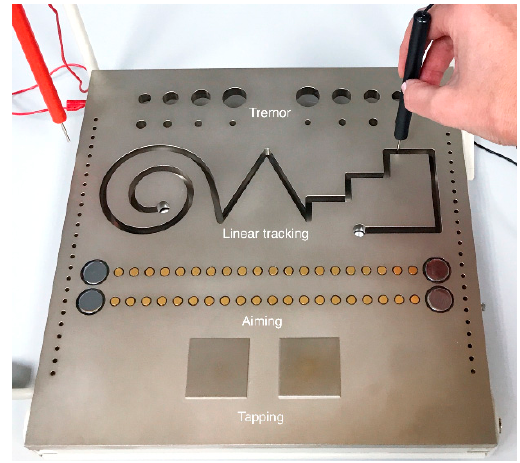
Figure 2. The MLS work panel.